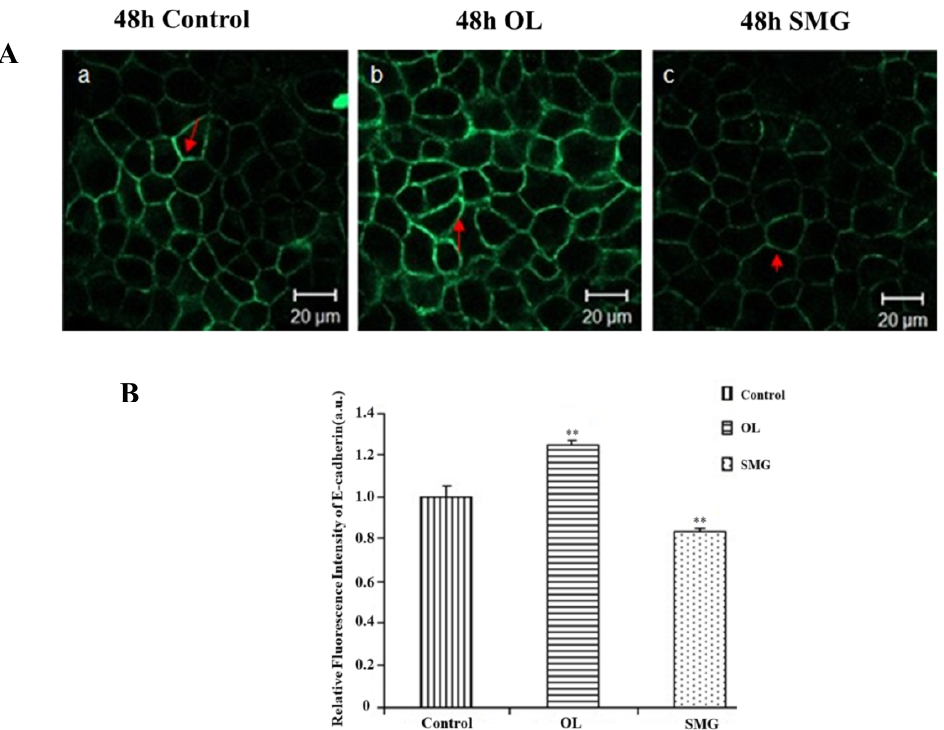
Figure 7. The expression of E-cadherin in MCF-7 cells after mechanical treatment. ( A ) The results of immunofluorescence experiments. The blue color indicates the nucleus, and the green color represents the paxillin protein. a. 48 h Control; b. 48 h Overload; c. 48 h SMG. ( B ) Relative fluorescence intensity of E-cadherin in MCF-7 cells after mechanical changes. Significant difference; ** p < 0.01, extremely significant.